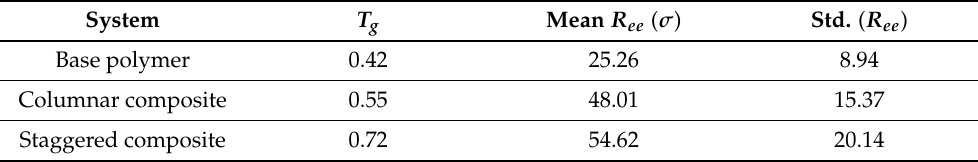
Table 1. Mean end-to-end distance R ee with standard deviation for the equilibrated base polymer and composite